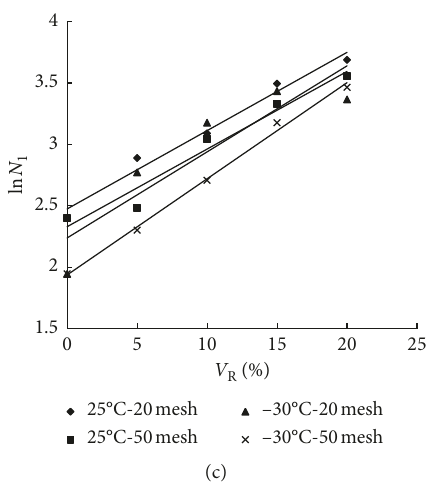
Figure 7: Relationship between ln N